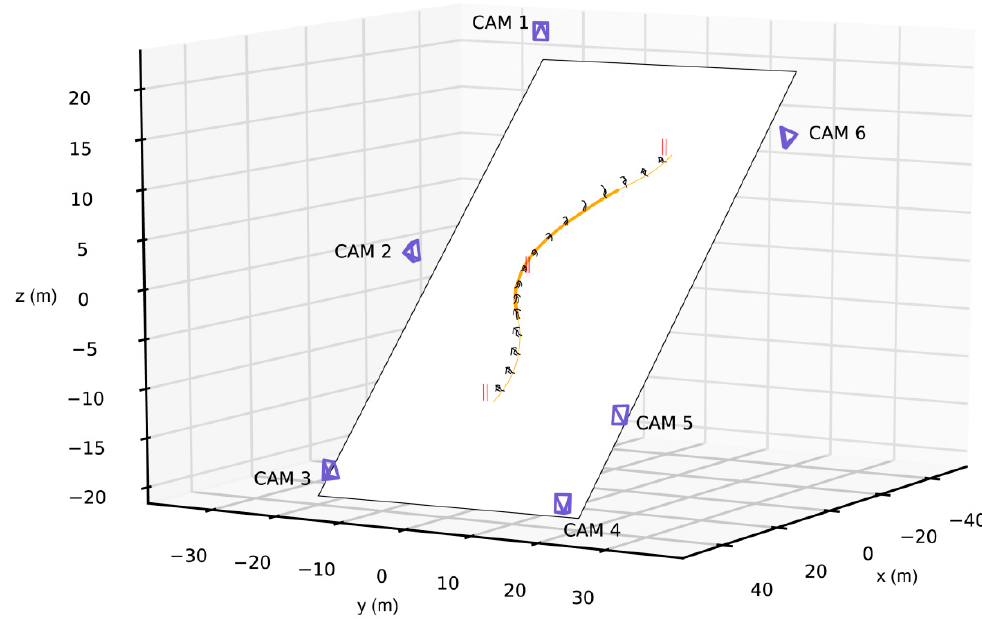
Figure 1. Setup overview visualizing the camera and gate positions measured in meters, as well as the capture volume spanned by three consecutive giant slalom gates. The small person size in relation to the camera distance highlights the difficulty in estimating skiing poses accurately.